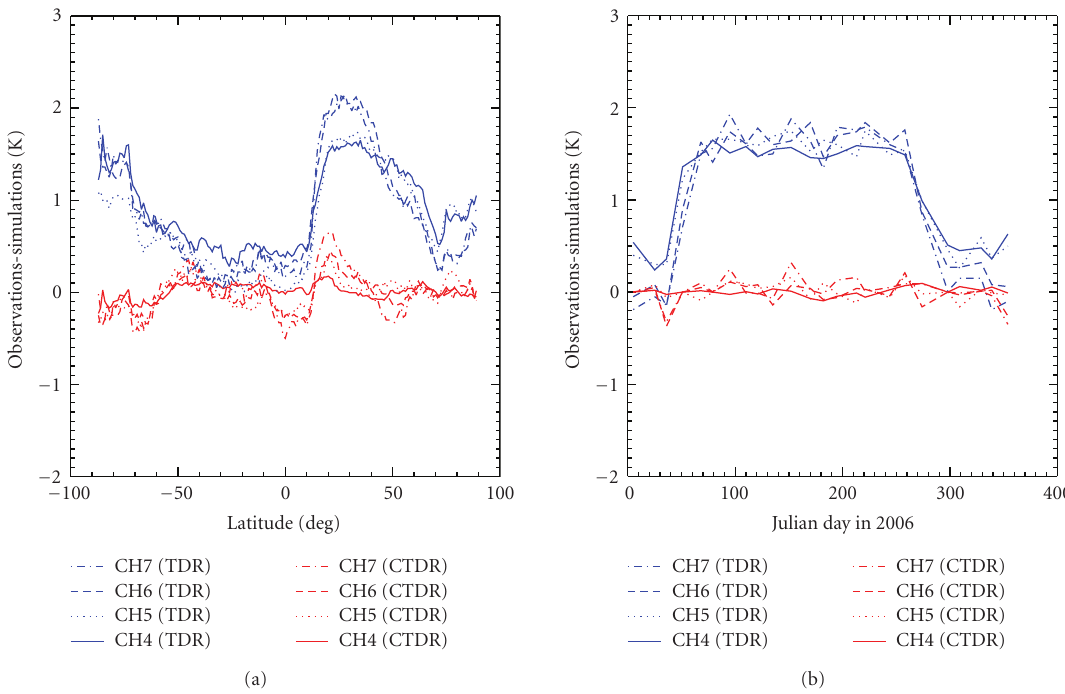
Figure 10: (a) Longitudinally averaged antenna temperature biases between F16 SSMIS TDR (CTDR) measurements and simulations at 54.4, 55.5, 57.3, and 59.4 GHz on June 19, 2006, and (b) time series of the longitudinally averaged antenna temperature biases at latitude of 50 ◦ N. In the figures, red is for newly calibrated while blue for original TDR